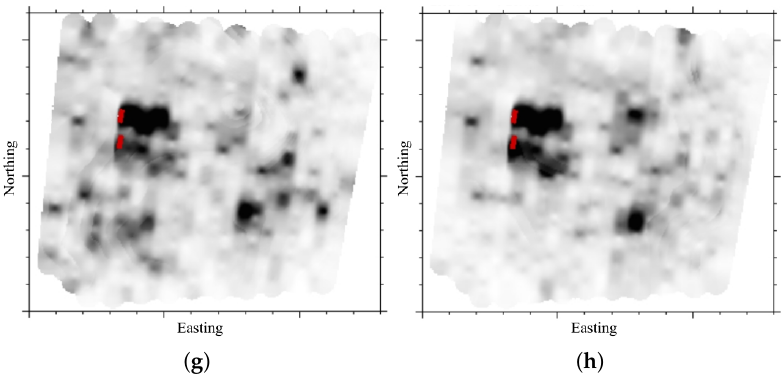
Figure 5. Side-by-side elevation slice comparisons between topographic corrections using elevations from ALS (left column) and TLS (right column). ( a , b ): The bottom of the railroad ties is visible at an elevation of 2.2 m using ALS and 2.4 m using TLS. Note the southwest corner of the TLS elevation slice is absent because the terrain is lower than the elevation slide made at 2.4 m. ( c , d ): The anomaly that was overprinted by ringing is at an elevation of 1.9 m using ALS and 2.1 m using TLS. ( e , f ): The southern confirmed burial is at an elevation of 1.3 m using ALS and 1.5 m using TLS. ( g , h ): The northern confirmed burial is at an elevation of 1 m using ALS and 1.3 m using TLS. ( a ) Railroad ties bottom, ele. = 2.2 m (ALS). ( b ) Railroad ties bottom, ele. = 2.4 m (TLS). ( c ) Overprinted anomaly, ele. = 1.9 m (ALS). ( d ) Overprinted anomaly, ele. = 2.1 m (TLS). ( e ) Southern burial, ele. = 1.3 m (ALS). ( f ) Southern burial, ele. = 1.5 m (TLS). ( g ) Northern burial, ele. = 1 m (ALS). ( h ) Northern burial, ele. = 1.3 m